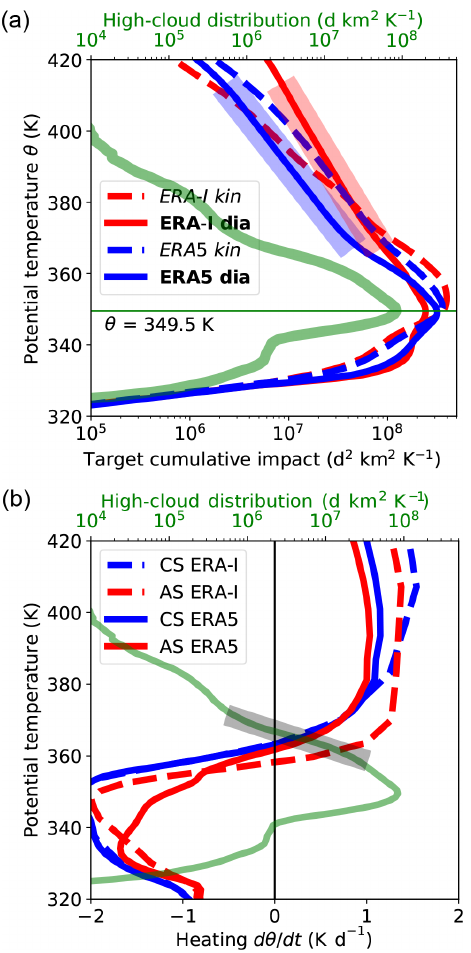
Figure 4. (a) Green: vertical distribution of the selected high-cloud tops. Other curves: vertical distribution of the cumulated impact within the FullAMA domain for the ERA5 diabatic (EAD, solid blue), ERA5 kinematic (EAZ, dashed blue), ERA-Interim diabatic (EID, solid red) and ERA-Interim kinematic (EIZ, dashed red) ex- periments. For EAD and EID, a fit with a logarithmic decrement, respectively 0.065 and 0.050K − 1 , is shown between 370 and 400K (wide segments). (b) Green: same as in (a) . Other curves: radiative heating rate profile average over the restricted domain (20–140 ◦ E and 10–40 ◦ N) for July and August 2017 and all-sky ERA5 (solid red), all-sky ERA-Interim (dashed red), clear-sky ERA5 (solid blue) and clear-sky ERA-Interim (dashed blue). The fit of the high-cloud distribution between 360 and 370K is shown with a logarithmic decrement β = 0 . 325K − 1 (wide grey